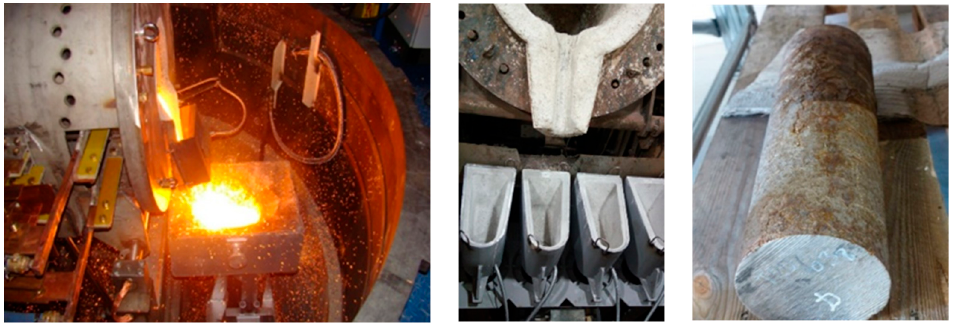
Figure 2. Preparation of experimental material. Table 1. Chemical composition of the heats in wt%.